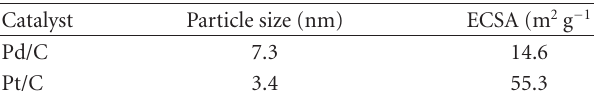
Table 1: ECSA and particle size for carbon-supported palladium